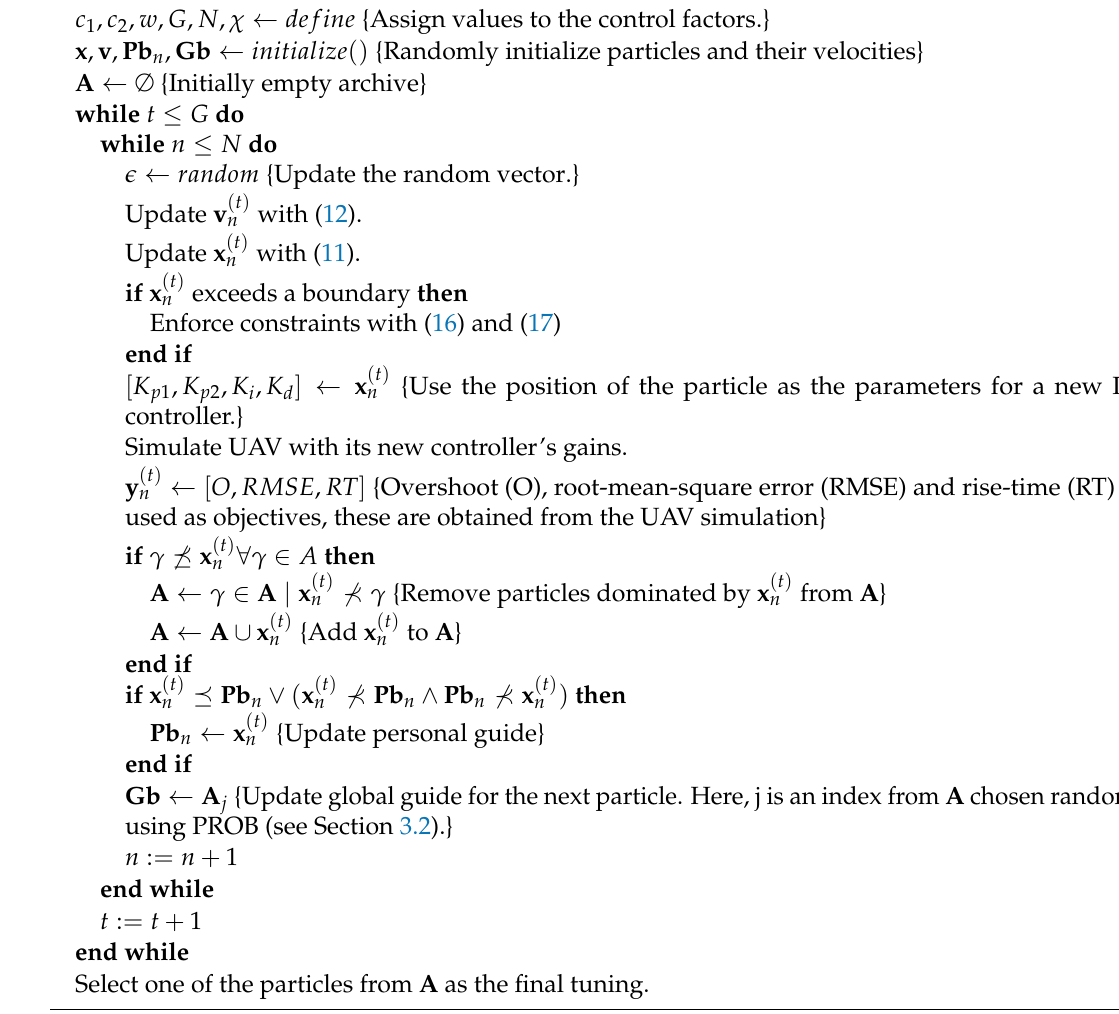
Algorithm 1 Proposed tuning procedure based on the MOPSO